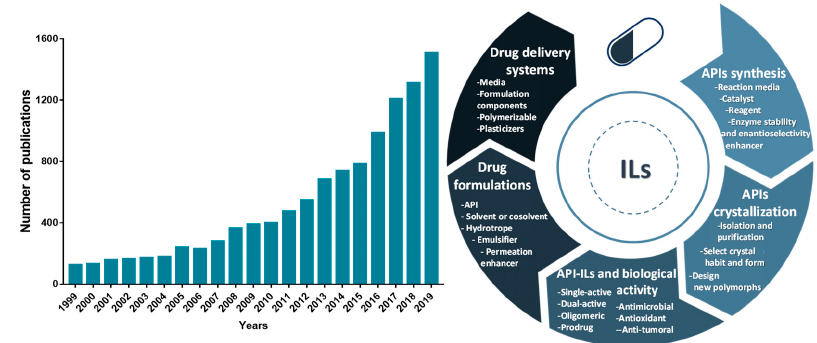
Figure 1. Number of publications per year in a twenty years perspective related to ILs and active pharmaceutical ingredients (APIs) (number of articles, reviews and book chapters according to a ScienceDirect database search using as keywords “ionic liquids”, “active pharmaceutical ingredients”, and “drug delivery”) ( left ). Overview of the ILs’ applications in the pharmaceutical field reported hitherto ( right ).